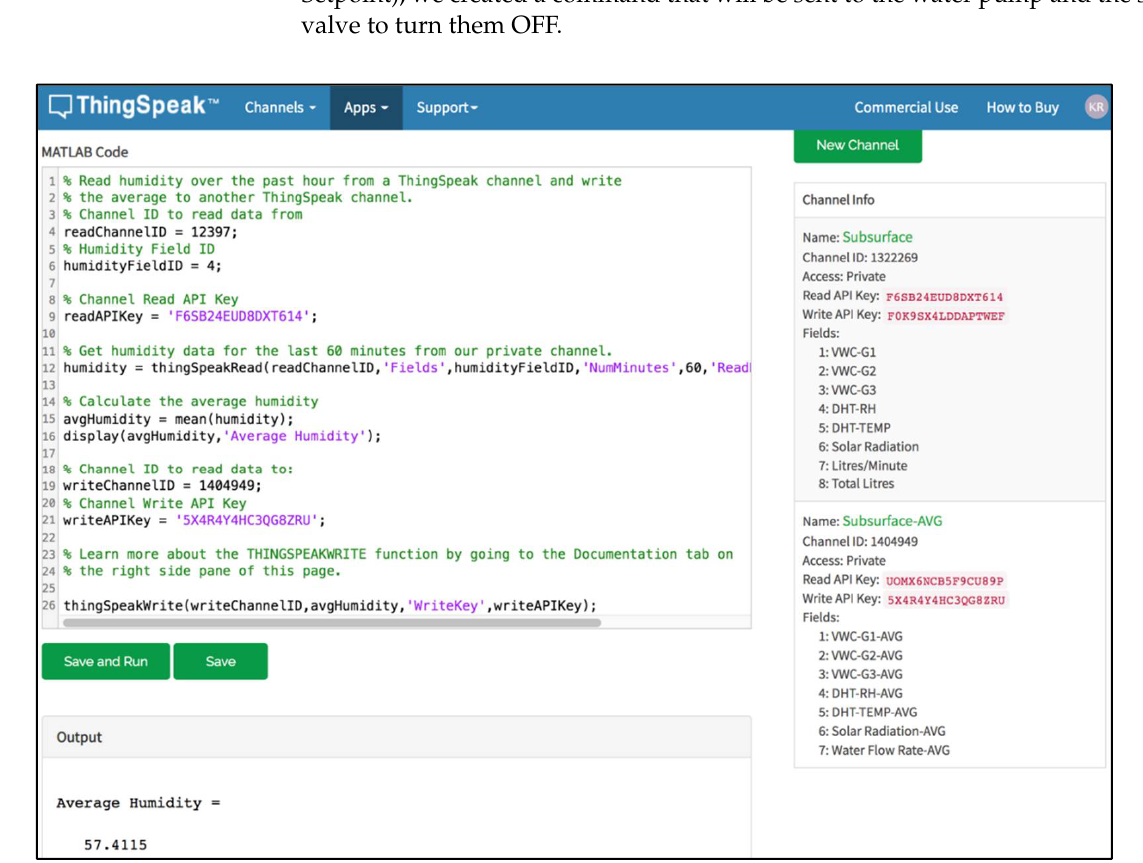
Figure 7. An example for calculating the average humidity over the past hour from our ThingSpeak channel and storing the results in another private channel on ThingSpeak using MATLAB Analysis.